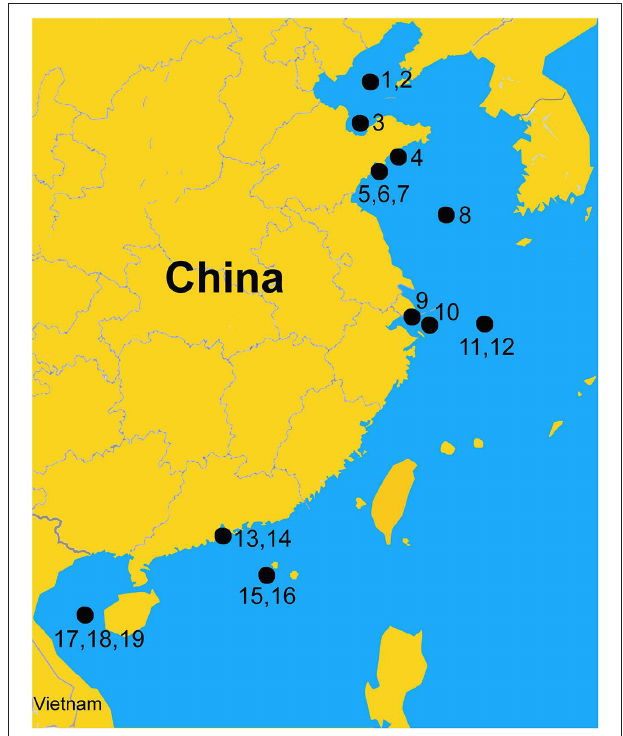
FIGURE 1 | Central point location of the area covered by 19 Ecopath models of China’s coastal